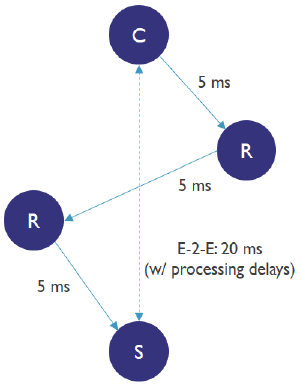
Figure 21. Topology for a three-hop network.